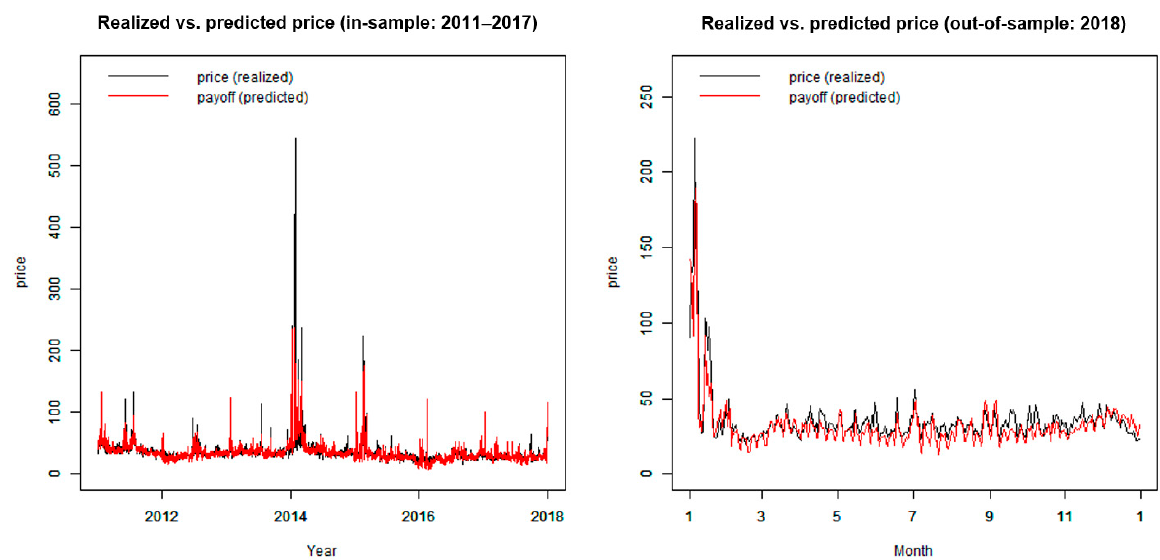
Figure A4. Comparison of realized and predicted values for the price model.